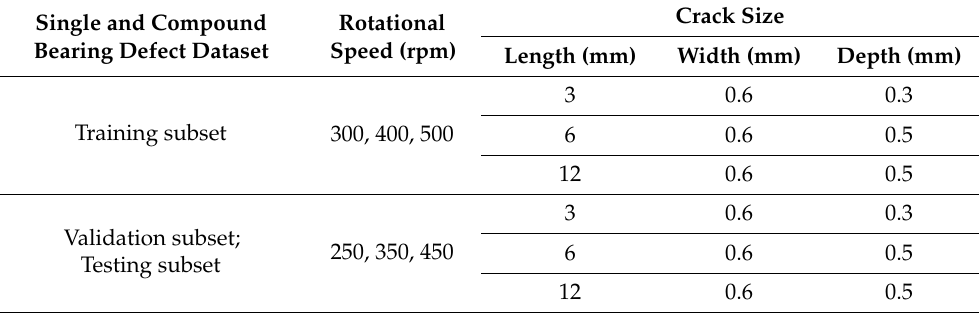
Table 2. Experimental compound fault with various levels of degradation dataset.